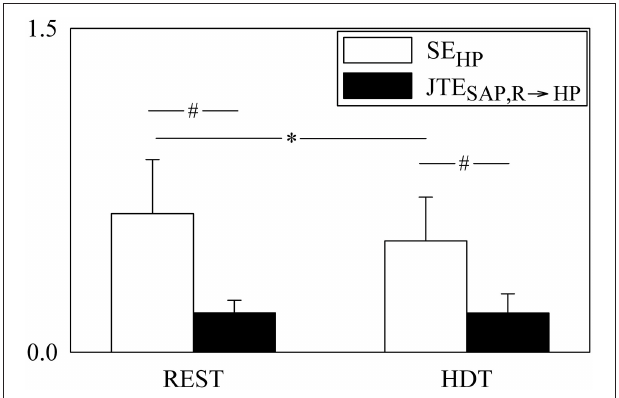
TABLE 1 | Results of time and frequency domain analyses of HP and SAP series. FIGURE 3 | The grouped bargraph shows the SE HP (white bars) and REST HDT JTE SAP,R → HP (black bars) assessed at REST and during HDT. SE HP and JTE SAP , R → HP are the two terms of the PE HP decomposition according to Equation (20). The values are reported as mean plus standard deviation. The symbol * indicates a significant difference between experimental conditions within the same index, while the symbol # indicates a significant difference between indexes within the same experimental condition with p < 0.05 .